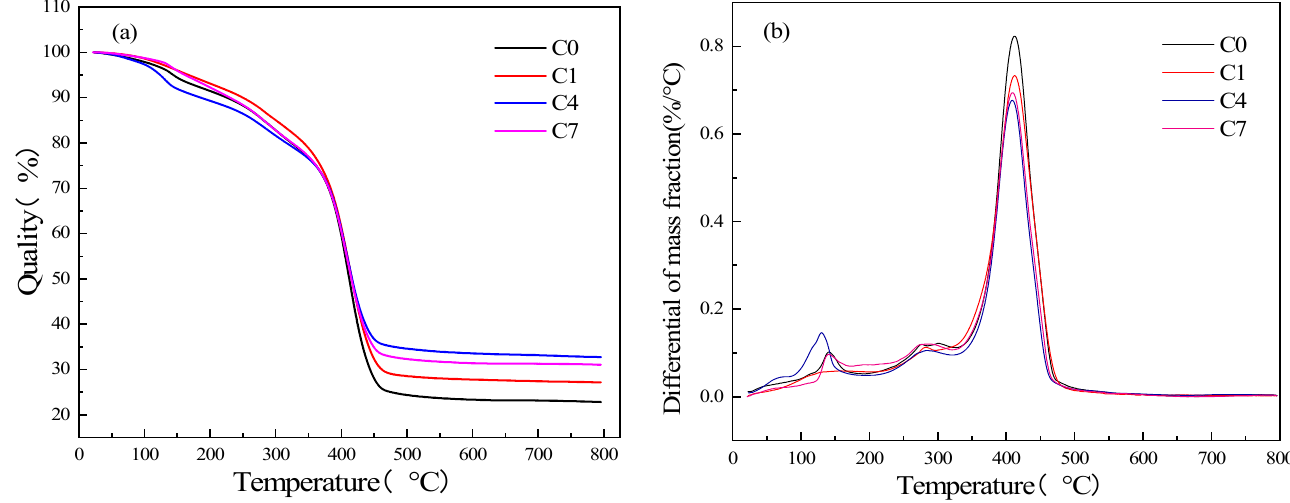
Figure 5. ( a ) The TG profiles of the four WPU coatings with and without modifications under inert atmosphere. ( b ) The DTG profiles of the four WPU coatings with and without modifications under inert atmosphere.